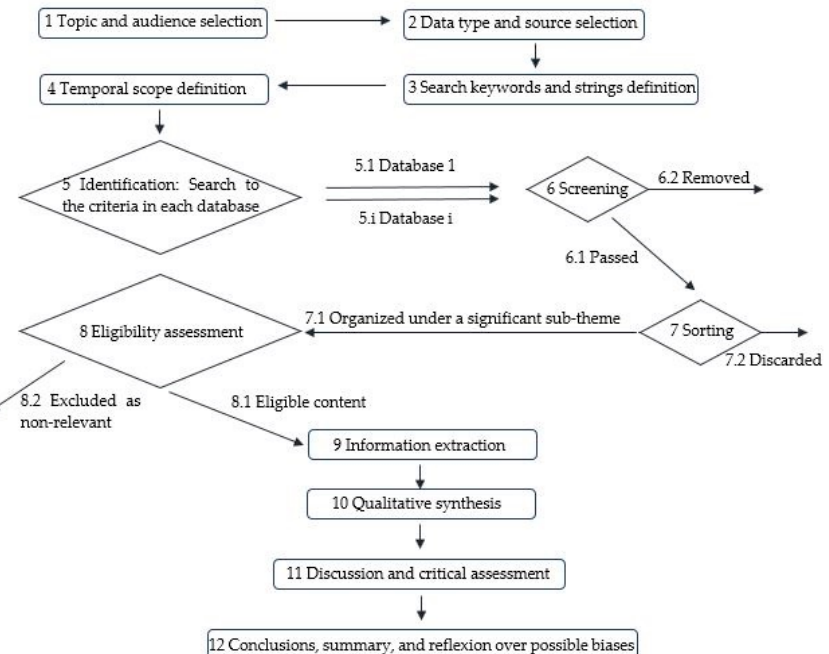
Figure 5. Search and systematic review methodology [5] reproduced under the Creative